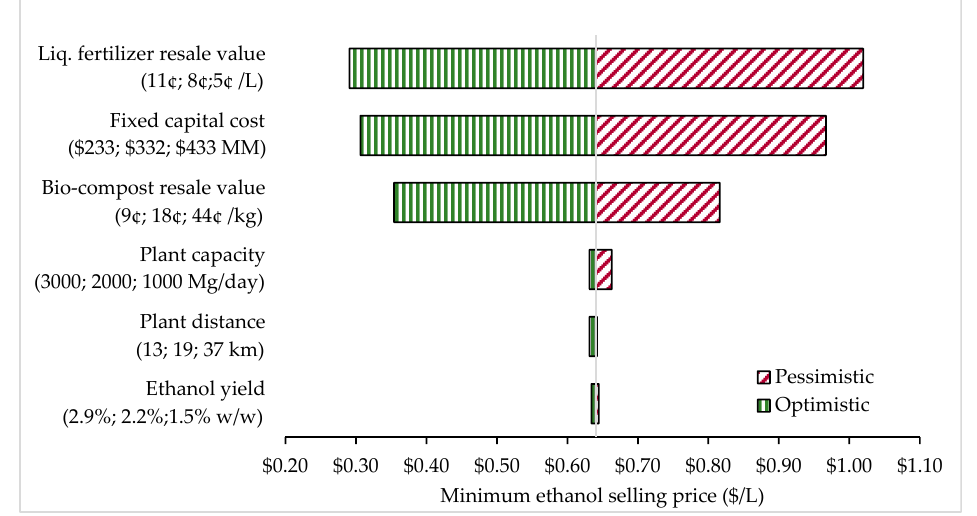
Figure 7. Sensitivity analysis for scenario A FW fermentation process, with hydrolysis enzymes and a 2-step distillation system. Optimistic is the best-case scenario simulation and pessimistic is the worst-case scenario simulation.